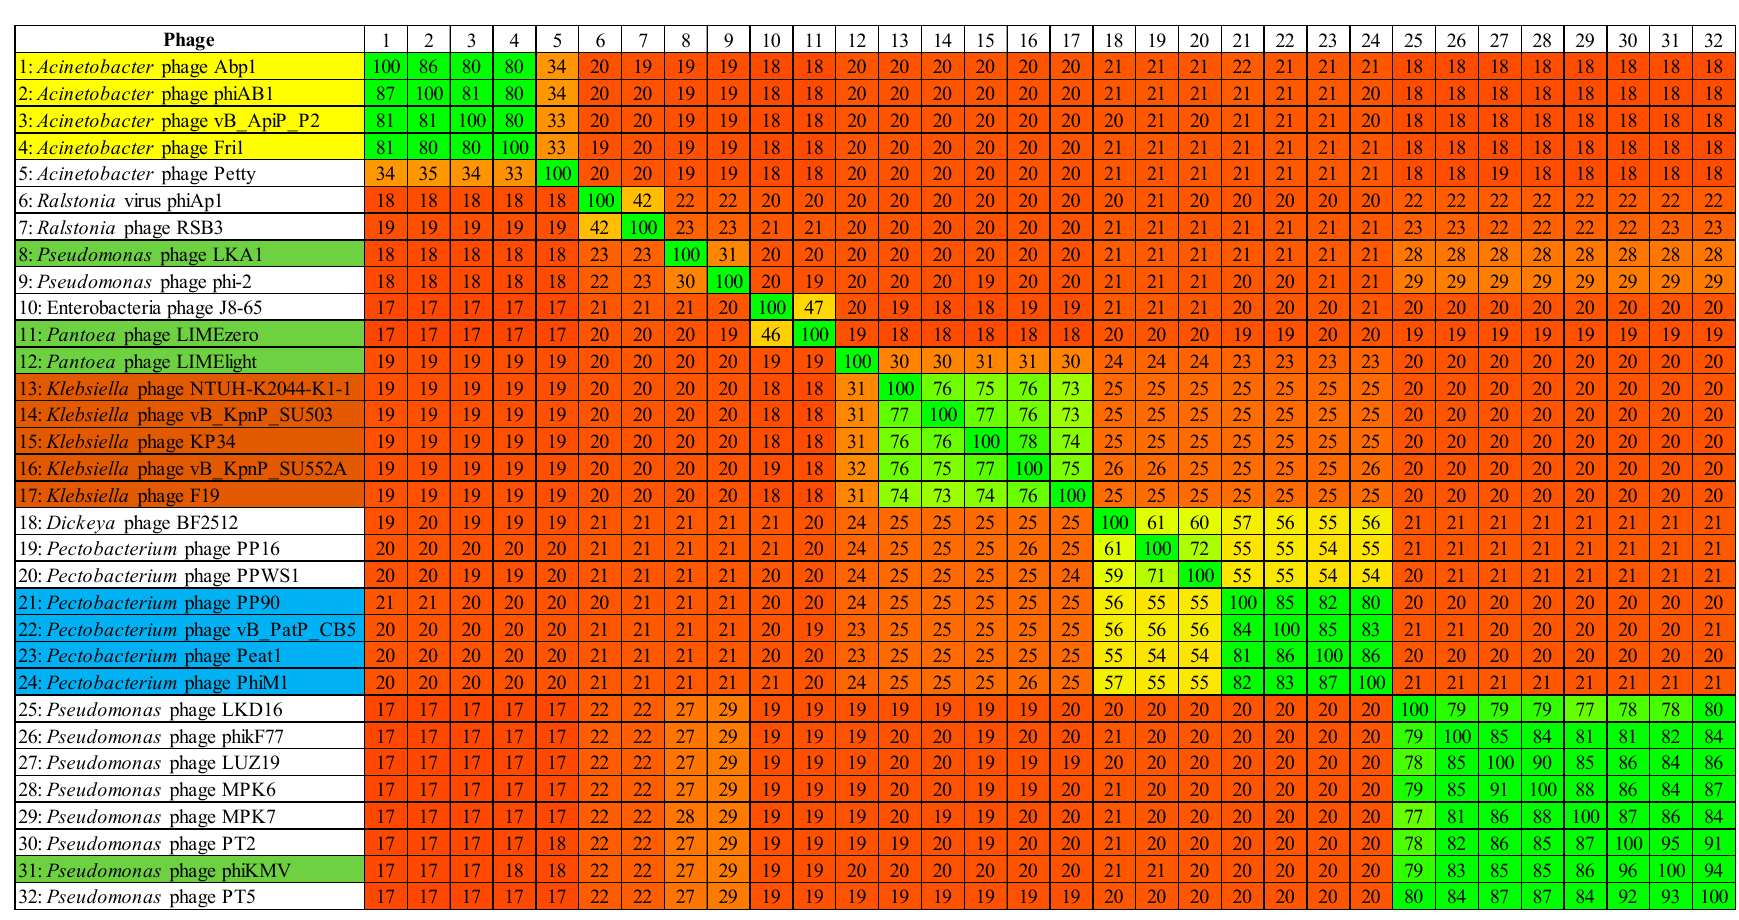
Figure 7. TBLASTX heat map generated using Gegenees with accurate parameters—fragment length: 200 bp; and step size: 100 bp with the threshold set to 5%. The map includes the genomes of 32 phages of Autographivirinae with phages representing the genera Fri1virus (yellow), KP34virus (brown), Phikmvvirus (green) and the proposed genus of ‘ Phimunavirus’ (blue). Plot colors reflect the identity, ranging from low (red) to high (green).